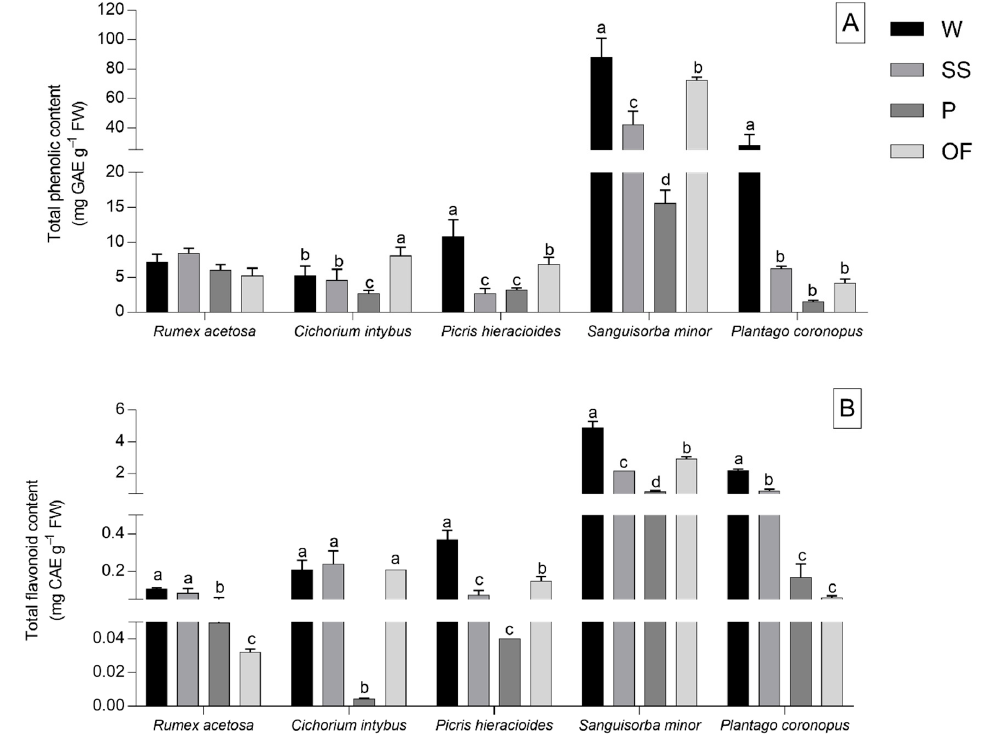
Figure 2. Total phenolic ( A ) and total flavonoid ( B ) contents of Rumex acetosa , Cichorium intybus , Picris hieracioides , Sanguisorba minor , and Plantago coronopus wild-collected (W) and domesticated according to three di ff erent methods: “soilless” (SS), pot (P), and open field (OF). Each value is the mean ( ± SD) of three replicates. Means keyed with a di ff erent letter are significantly di ff erent for p = 0.05 di ff erent domestications as the variability